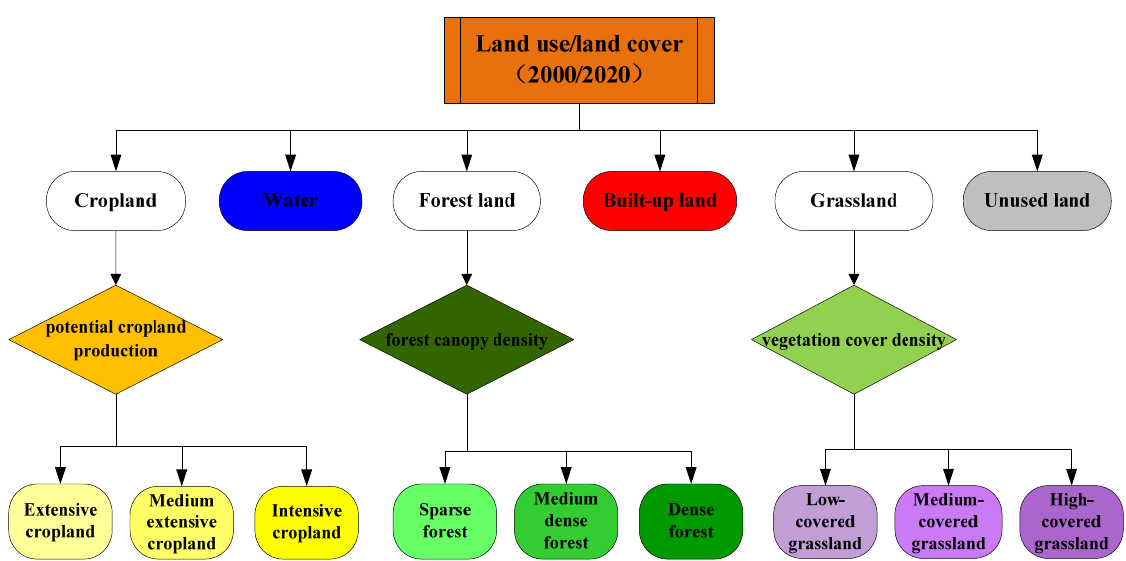
Figure 3. Approaches to land system